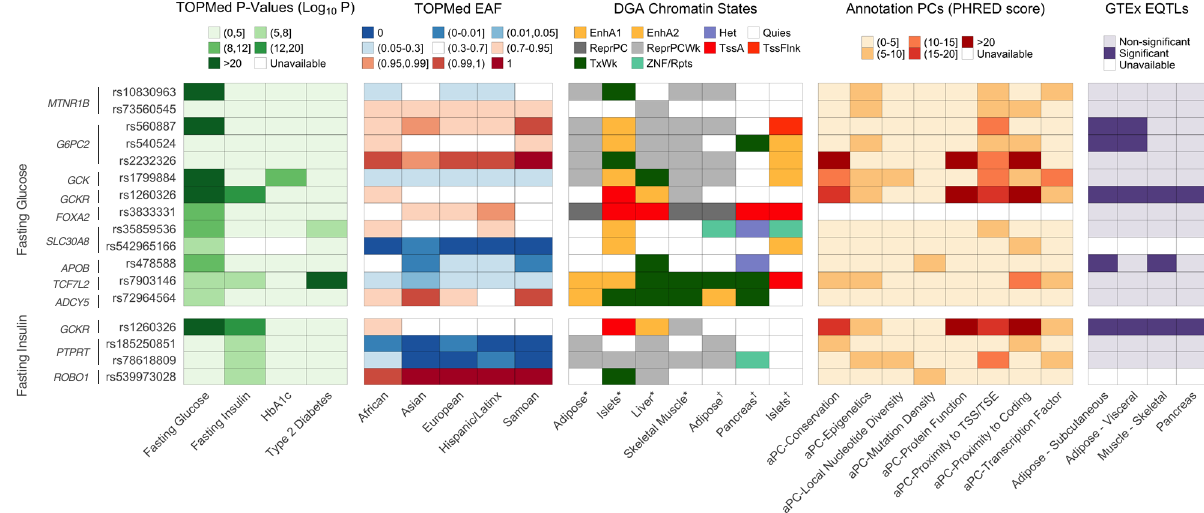
Fig. 1 Characterization of signi fi cant and suggestive single-variant signals associated with fasting glucose and fasting insulin in TOPMed. TOPMed features of distinct, signi fi cant and suggestive signals associated with fasting glucose and fasting insulin (log-transformed) in pooled analysis. P -values (unconditional − log10-transformed) for glycemic and related traits (HbAa1c and type 2 diabetes) and effect allele frequency (with respect to the pooled analysis effect allele) across race/ethnicities in TOPMed are reported. Chromatin states at relevant tissues were drawn from two sets of experiments from DGA 46,47 ; annotation PCs provide summaries of multi-faceted variant function; variants that are signi fi cant eQTLs in relevant tissues are denoted. EAF, effect allele frequency for TOPMed sample; EnhA1, Active Enhancer 1; EnhA2, Active Enhancer 2; Het, Heterochromatin; Quies, Quiescent/Low; ReprPC, Repressed PolyComb; ReprPCWk, Weak Repressed PolyComb; TssA, Active TSS; TssFlnk, Flanking TSS; TxWk, Weak Transcription; ZNF/Rpts, ZNF genes &